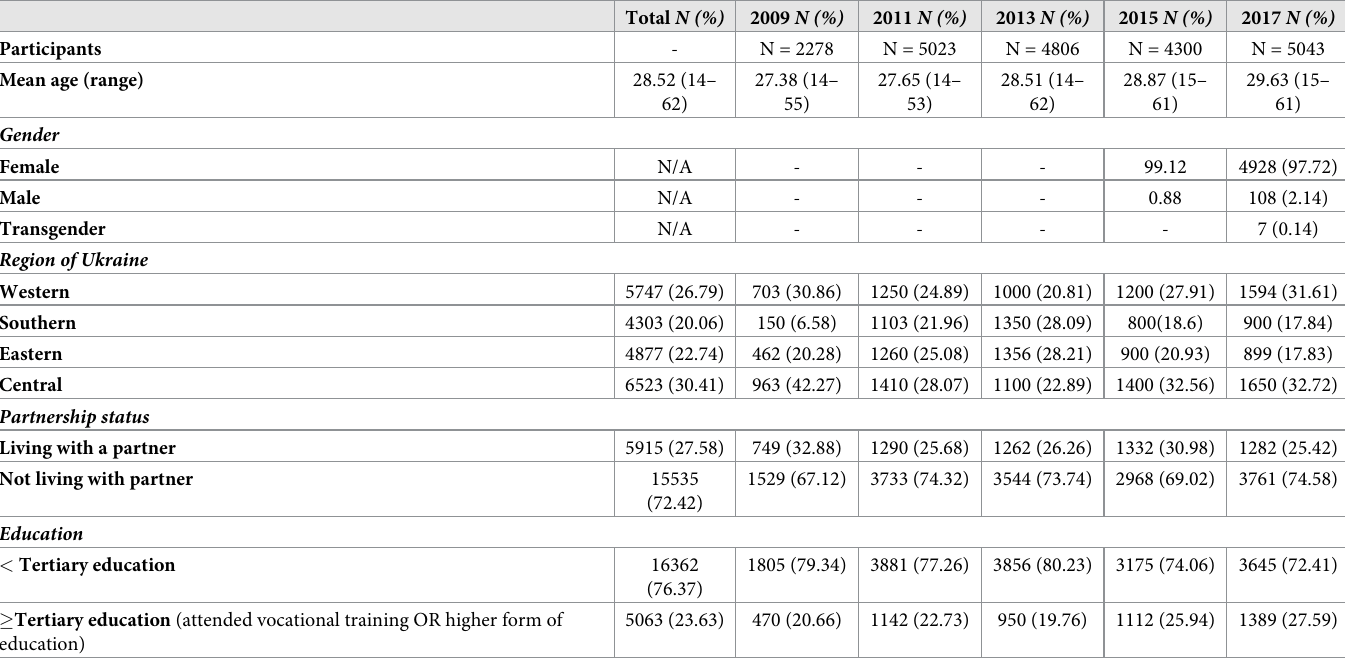
Table 3. Demographic characteristics of participants in